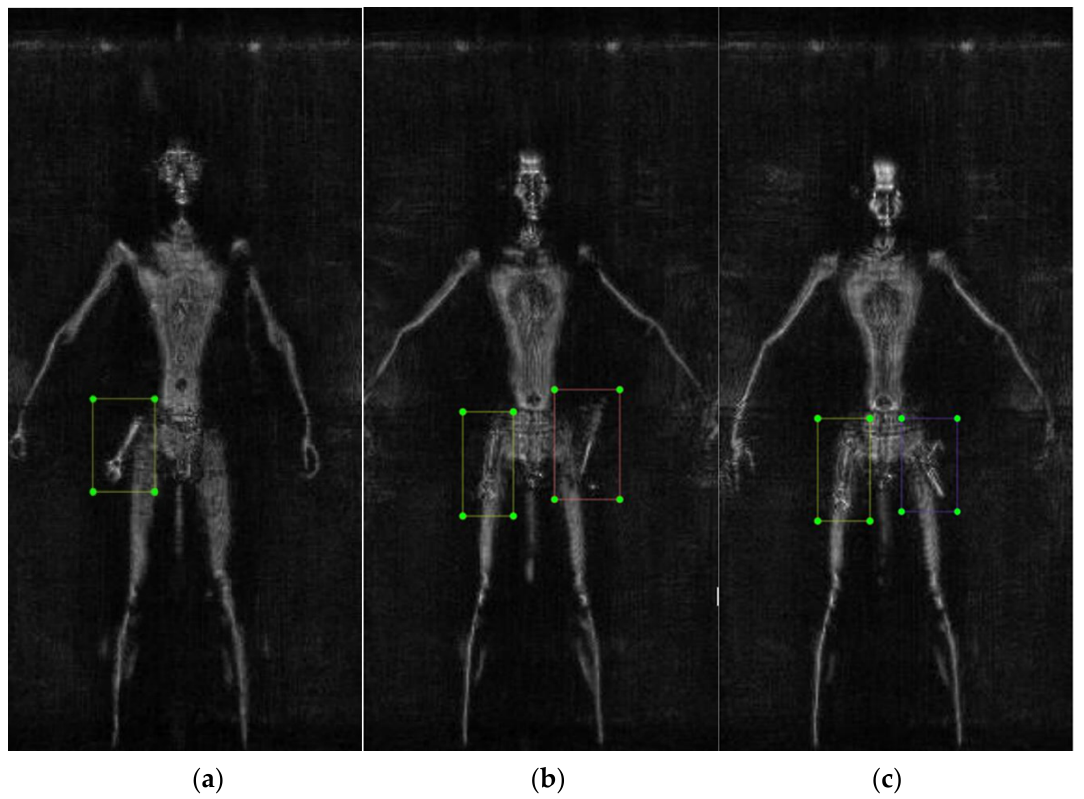
Figure 4. LabelImg images. ( a ) Wrench image marking diagram. ( b ) Wrench and hammer image marking diagram. ( c ) Wrench and pistol image marker diagram.